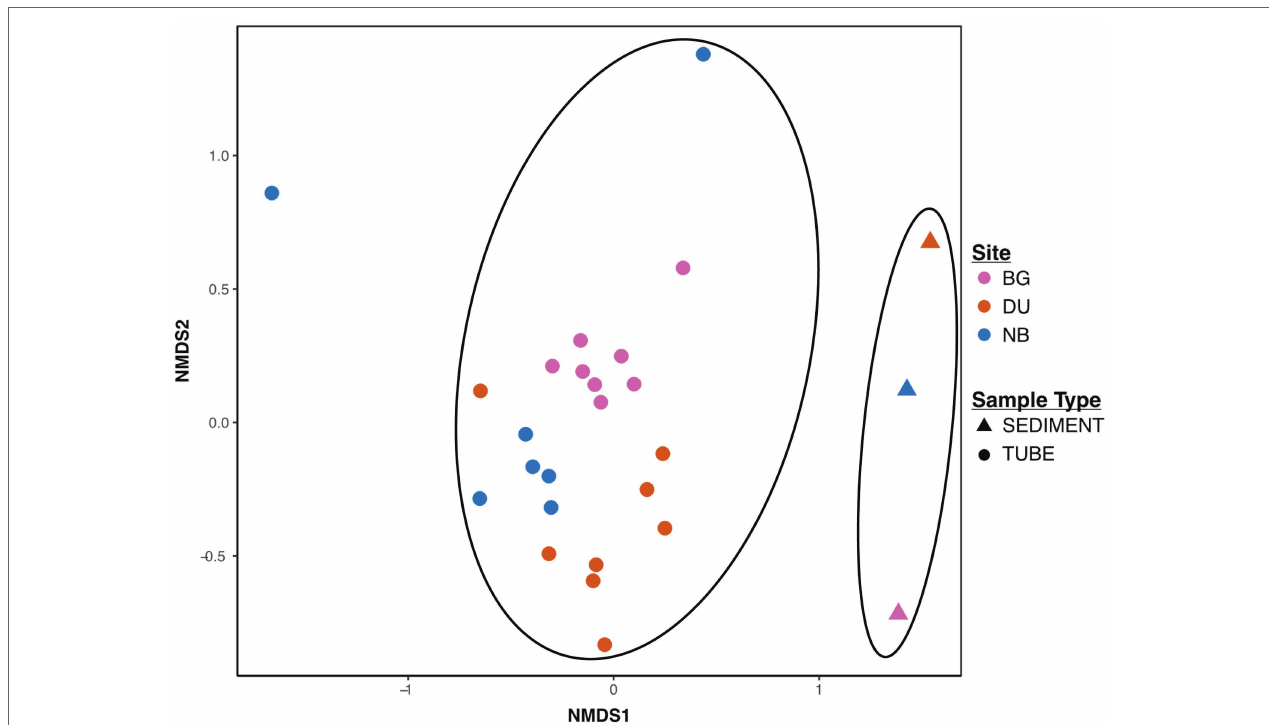
FIGURE 2 | Beta diversity of microbiomes of tubes and sediment samples relative to each sample site. Data presented as a non-metric multidimensional scaling (NMDS) plot based on Bray-Curtis dissimilarity values. Multivariate ADONIS models showed strong effects of sample type on Bray-Curtis dissimilarities (Sample Type: F 24,1 = 4.0, R 2 = 0.14, p = 0.001) and site (Site: F 23,2 = 2.8, R 2 = 0.19, p = 0.001) on distinct clustering of Bray-Curtis distances. Ellipses indicate distinct beta diversity of the microbiome between tubes and sediment